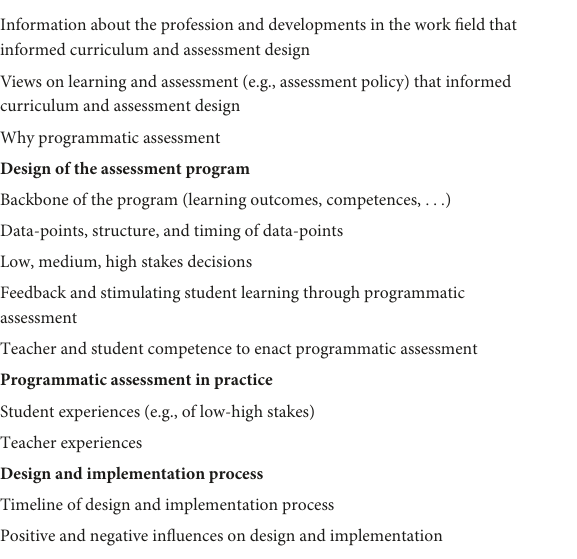
TABLE 3 Interview guide for semi-structured interviews.